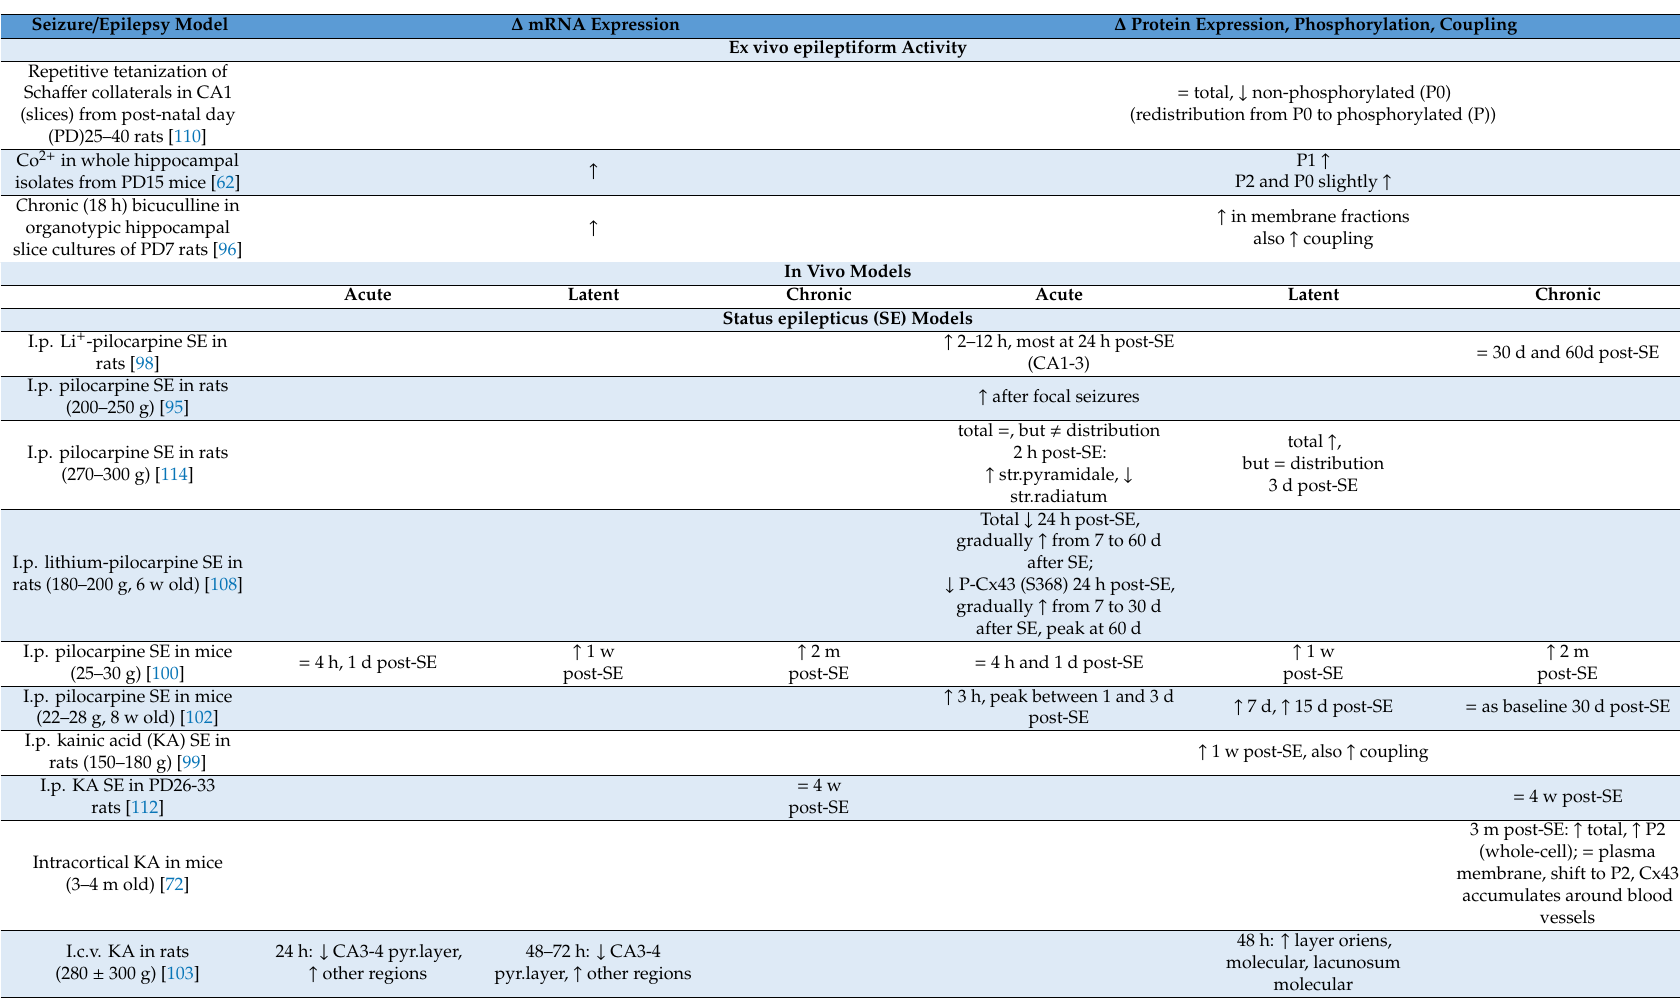
Table 2. Cx43 expression and phosphorylation changes in the hippocampus in rodent models of seizures and epilepsy. Seizure / Epilepsy